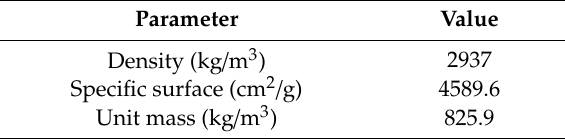
Table 1. Characteristics of the ordinary Portland cement (type I), used in the composite.